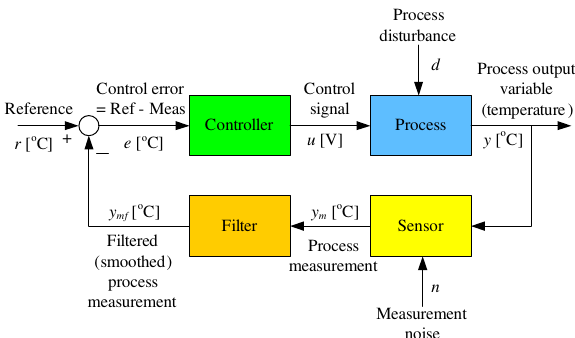
Figure 2: Block diagram of the temperature control